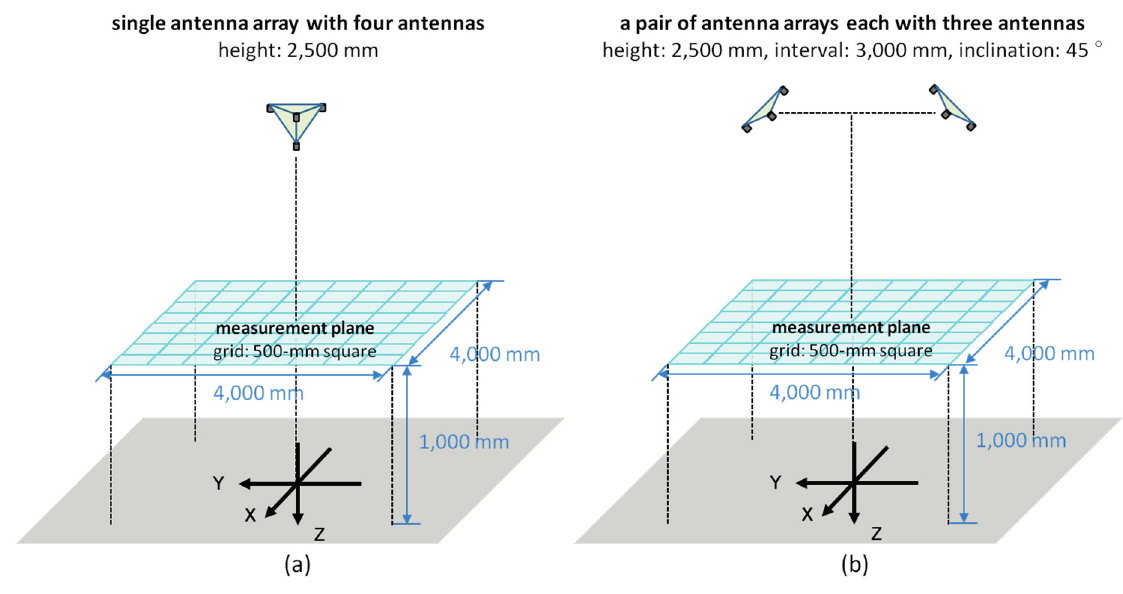
Figure 10. Simulation setup with ( a ) single antenna array and ( b ) double antenna